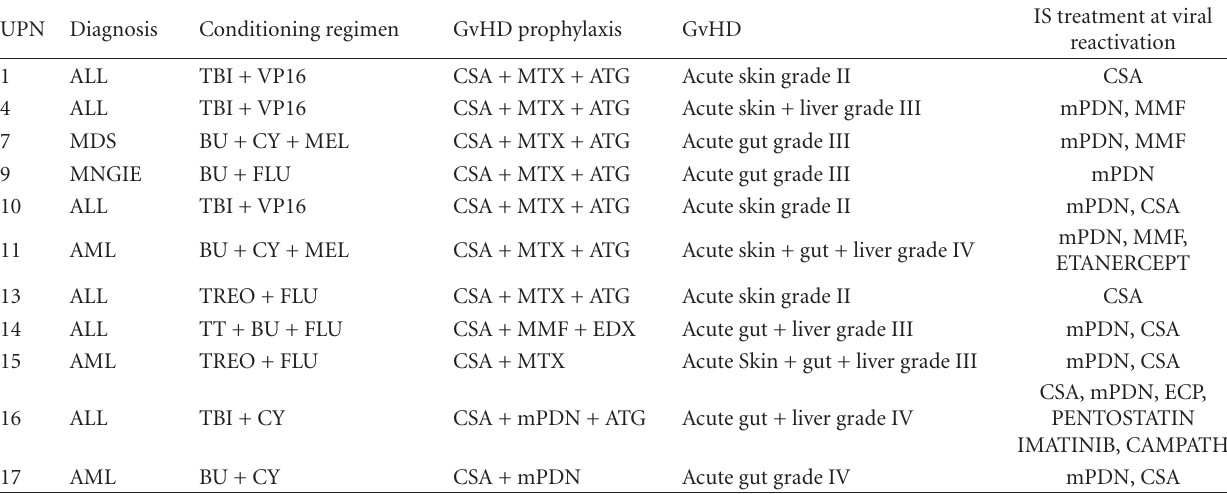
Table 1: Patients characteristics.